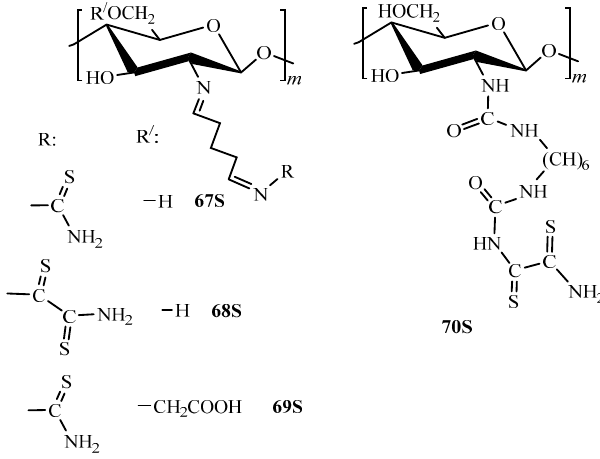
Figure 8. Structures of S-containing derivatives of chitosan with linker: 67S —thiourea derivative of chitosan; 68S —rubeanic acid derivative of chitosan; 69S —thiourea-modified chitosan resin (thiourea-modified carboxymethyl chitosan); 70S —sulfur derivative of chitosan (rubeanic acid derivative of chitosan cross-linking with hexamethylene diisocyanate).